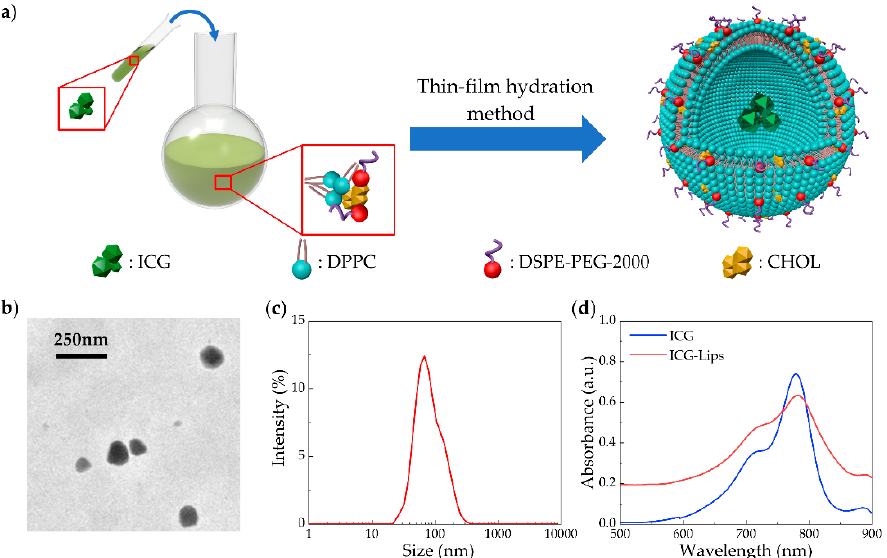
Figure 6. Schematic of the preparation process and the characterization of ICG-Lips. ( a ) ICG-Lips are generated by the thin-film hydration method. ICG, indocyanine green. DPPC, dipalmitoyl phos- phatidylcholine. DSPE-PEG, 1,2-distearoyl-sn-glycero-3-phosphoethanolamine-N-[amino (polyeth- ylene glycol) 2000]. CHOL, cholesterol; ( b ) Transmission electron microscope (TEM) image of ICG-Lips; ( c ) Size distribution of ICG-Lips (z-average 129 ± 49 nm); ( d ) UV-Vis spectra of ICG and ICG-Lips in phosphate-buffered saline.